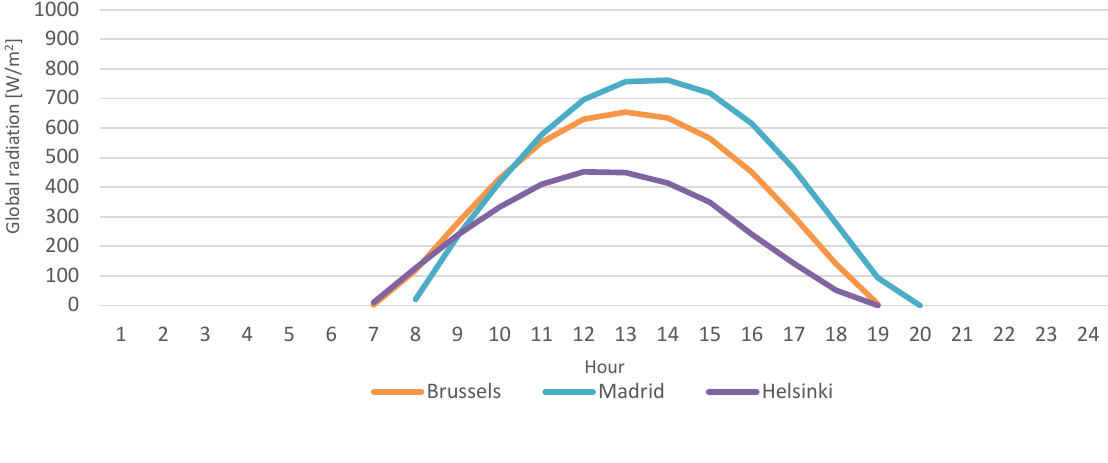
Fig. 4: Solar radiation for horizontal glazing in spring